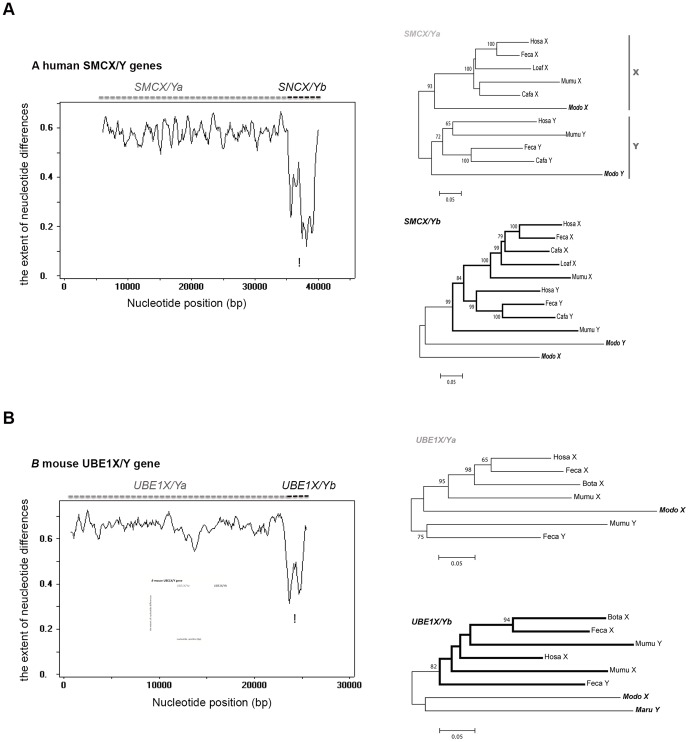
Window analysis of nucleotide divergence and phylogenic relationship of human SMCX/Y (A) and mouse UBE1X/Y (B) genes.The entire genomic sequences of genes were compared in a window analysis. The window size was 500 bp, with no overlap between adjacent windows. The ordinate represents the extent of nucleotide differences and the abscissa represents position (bp). Position 1 corresponds to the beginning of exon 1 of the X-linked gene. The asterisks indicate the areas showing a statistically significant reduction in nucleotide divergence (SMCX/Y: ∼5 kb, UBE1X/Y: ∼2 kb). The unrooted tree was based on the number of synonymous differences per site. A bootstrap value of more than 50% is indicated at each node. A vertical gray bar shows a monophyletic cluster of X- or Y-linked genes. Bold branches in B show a eutherian cluster of both X- and Y-linked genes. OTU names in bold are marsupials. The abbreviations for species names are the same as those in Fig. 2. (A) The tree of the 5′ region of the gene (SMCX/Ya; exons 1–10) is shown in the left panel and that of the 3′ region (SMCX/Yb; exons 11-end) is shown in the right panel. The number of synonymous sites compared was 404 bp (SMCX/Ya) or 972 bp (SMCX/Yb) without gaps, and 11 OTUs were used. (B) The tree of the 5′ region of the gene (UBE1X/Ya; 1–1000 bp) is shown in the left panel and that of the 3′ region (UBE1X/Yb; 1001–3180 bp) is shown in the right panel. The number of synonymous sites compared was 332 bp (UBE1X/Ya) or 151 bp (UBE1X/Yb) without gaps, and 7 OTUs or 8 OTUs were used. In UBE1X/Ya, MaruY could not be included because of missing data.